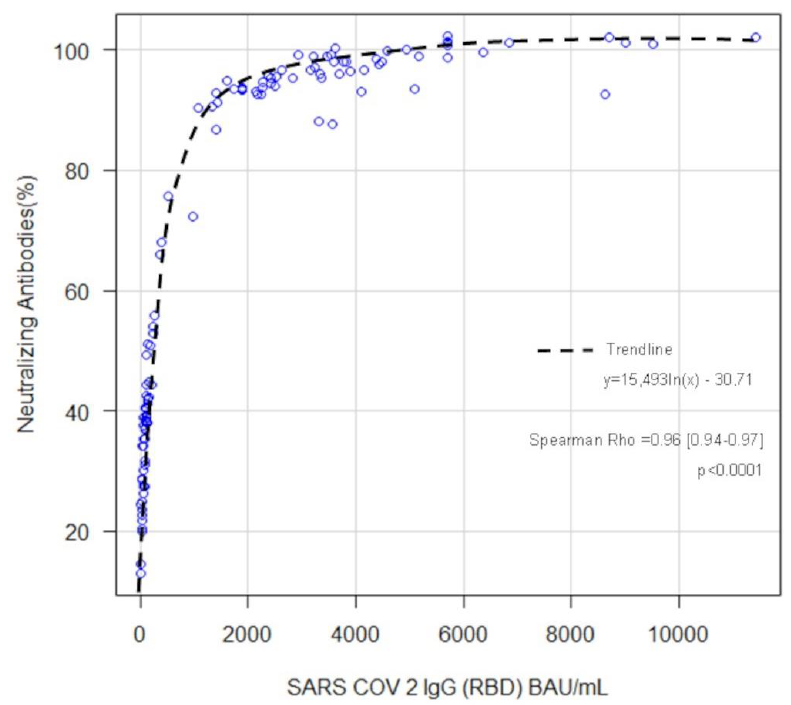
Figure 1. Anti-SARS-CoV-2- IgG and Neutralizing antibodies (Nab) correlation. Anti-RBD IgG levels are plotted against neutralizing-antibody-mediated percentage inhibition. The trend line equation is depicted in the picture: Nab% inhibition = 15,493 ln(x) − 30.71. Spearman Rho correlation was 0.96 ( p < 0.001). Blue circles correspond to single value determination.